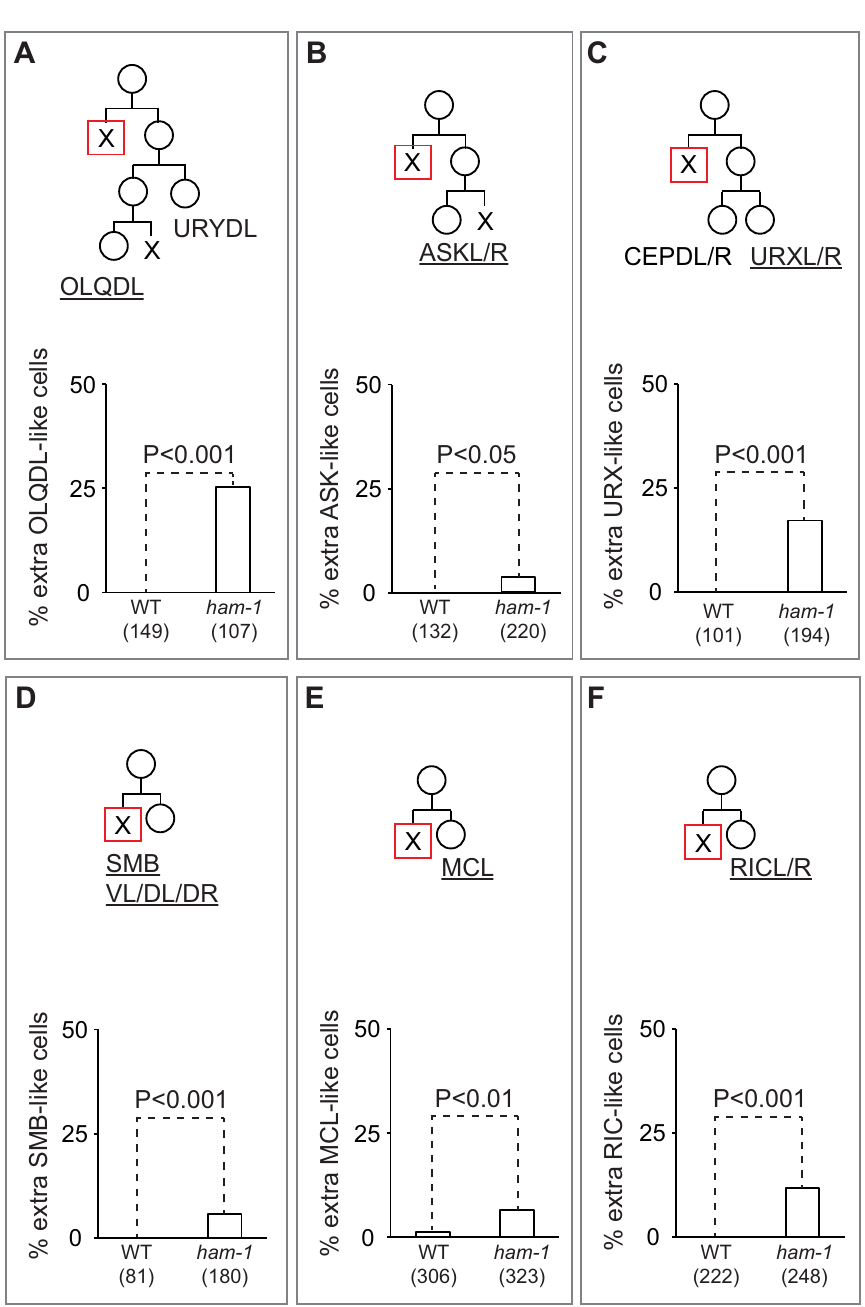
Fig 2. Abnormal numbers of neurons in nine neuroblast lineages that produce an anterior apoptotic daughter cell. (A) OLQDL, (B) ASKL/R, (C) URXL/R, (D) SMBVL/DL/DR, (E) MCL and (F) RICL/R lineage diagrams (upper panels) and the frequency of at least one extra neurons produced in wild-type (WT) and ham-1 mutant animals (lower panels). For each lineage, the neurons labelled are underlined on the diagram. Cells fated to die are indicated by an x, the anterior dying cell in each lineage is indicated by an x in a red square. The number of animals scored is indicated in parenthesis below each genotype.